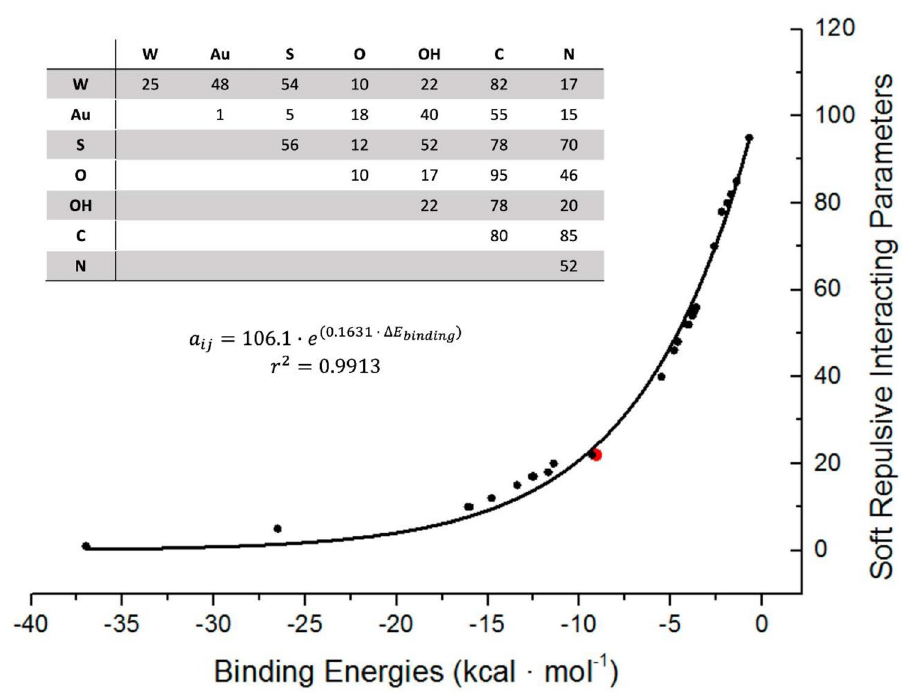
Figure 7. Exponential correlation plot between binding energies at LANDL2DZ/M062X level vs. DPD SRP. Red point represents water-water bead interaction (SRP W/W). Inset: Set of resultant SRP used in this